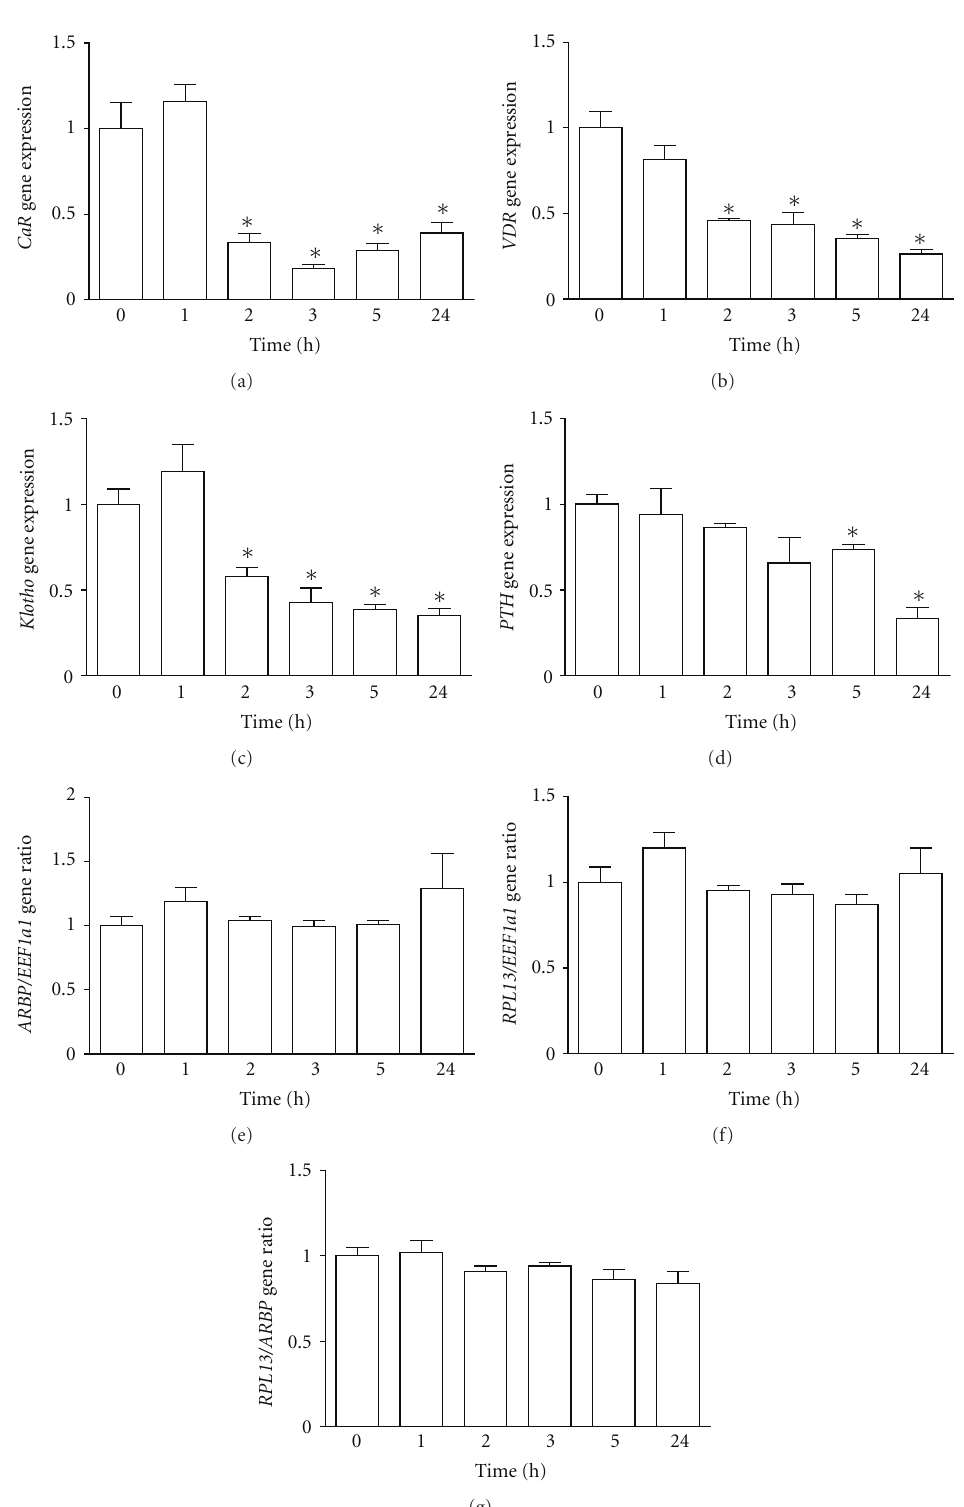
Figure 4: In vitro expression of CaR, VDR, klotho , and PTH in parathyroid tissue cultures over time. (a)–(d): gene expression of CaR, VDR, klotho , and PTH over time. (e)–(g): gene expression of housekeeping genes EEF1a1, ARBP , and RPL13 over time. ( ∗ ) Statistical significance of P < 0 . 05 is indicated, when compared to the zero-hour group. Gene activity is shown as gene